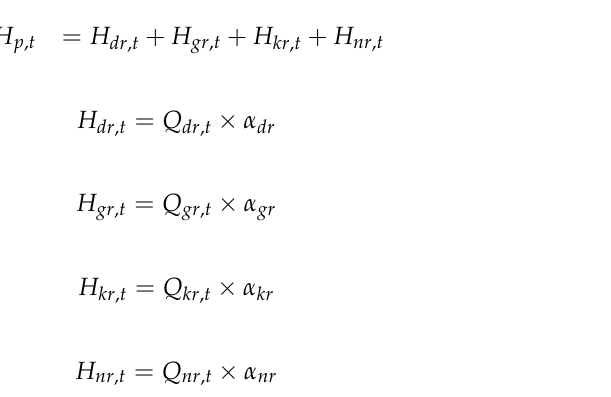
Figure 4. Model of petroleum refining